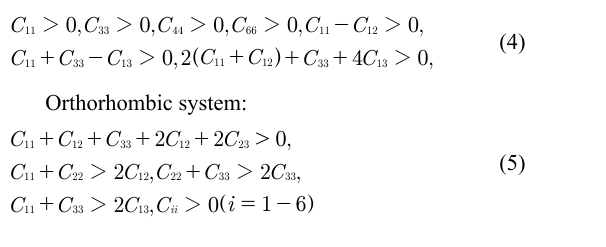
Table 2. The calculated elastic constants (C